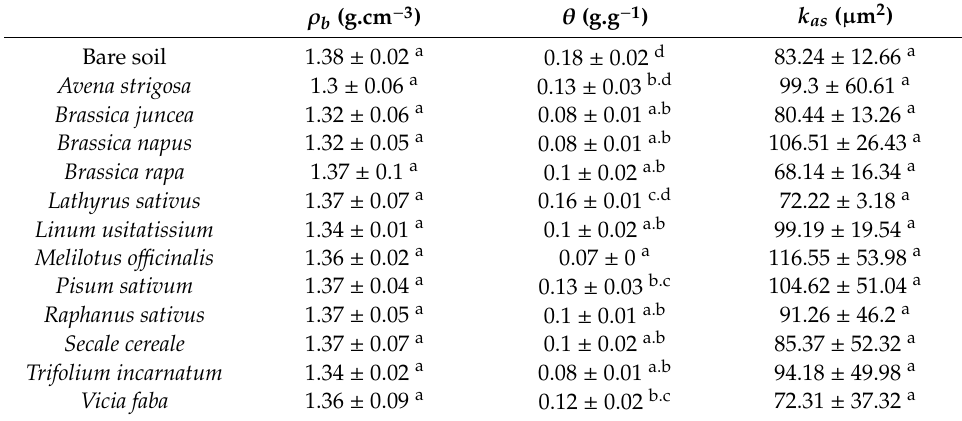
Table 2. Soil physical properties value per species.